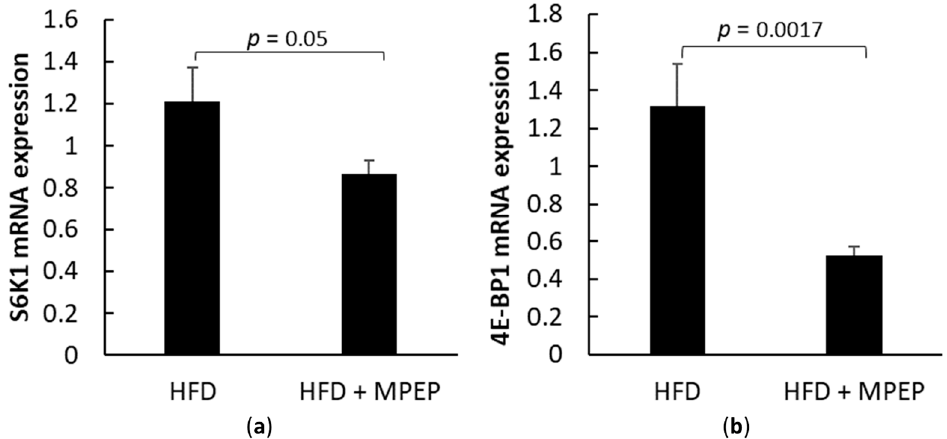
Figure 7. mTORC1 target genes in obese mice. ( a ) mTORC1 target gene S6K1 mRNA expression in liver from obese mice after 7 weeks of HFD administration, treated with MPEP 20 mg/Kg or vehicle; ( b ) 4E-BP1 mRNA expression in liver from obese mice after 7 weeks of HFD ad-ministration, treated with MPEP 20 mg/Kg or vehicle. Results are mean ± SE of 6 individual determinations.2.4. MPEP ameliorates oxidative stress and reduces the activation of pro-in fl ammatory NF- κ B. Lipid-induced over-production of reactive oxygen species (ROS) was traditionally considered the second hit in NAFLD pathogenesis [33] and is currently believed to be one of the concurring causes of NAFLD pathogenesis and progression [4]. During NAFLD development, ROS production worsens the scenario because it contributes to various other insults, such as cytokine-mediated in fl ammation, free fa tt y acid oxidation, apoptosis, necroin fl ammation, and fi brosis [33]. In this work, ROS were assayed using the fl uorescent probe dihydro-dichloro fl uorescein (DCFH). Thiobarbituric acid-reactive substance (TBARS) assay was used as an index of oxidative stress. In the MPEP group, a signi fi cant reduction of both TBARS and ROS was found, suggesting that daily MPEP of 20 mg/Kg reduces ROS production and, in the long run, oxidative stress caused by HFD (Figure 8a,b).